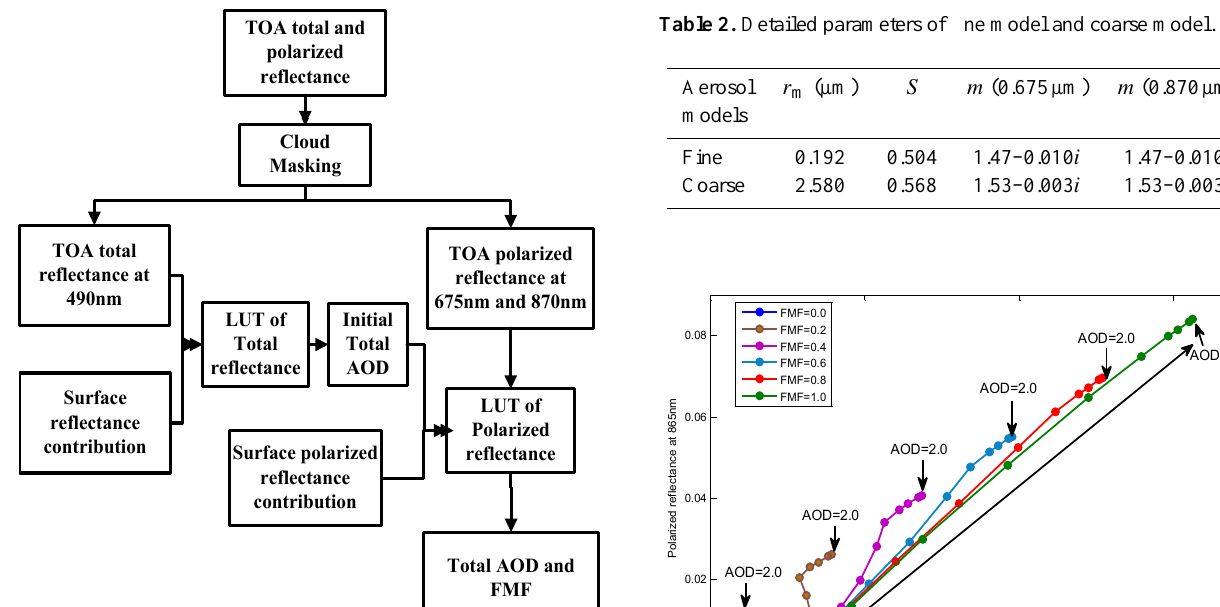
and the adjusted Total AOD.